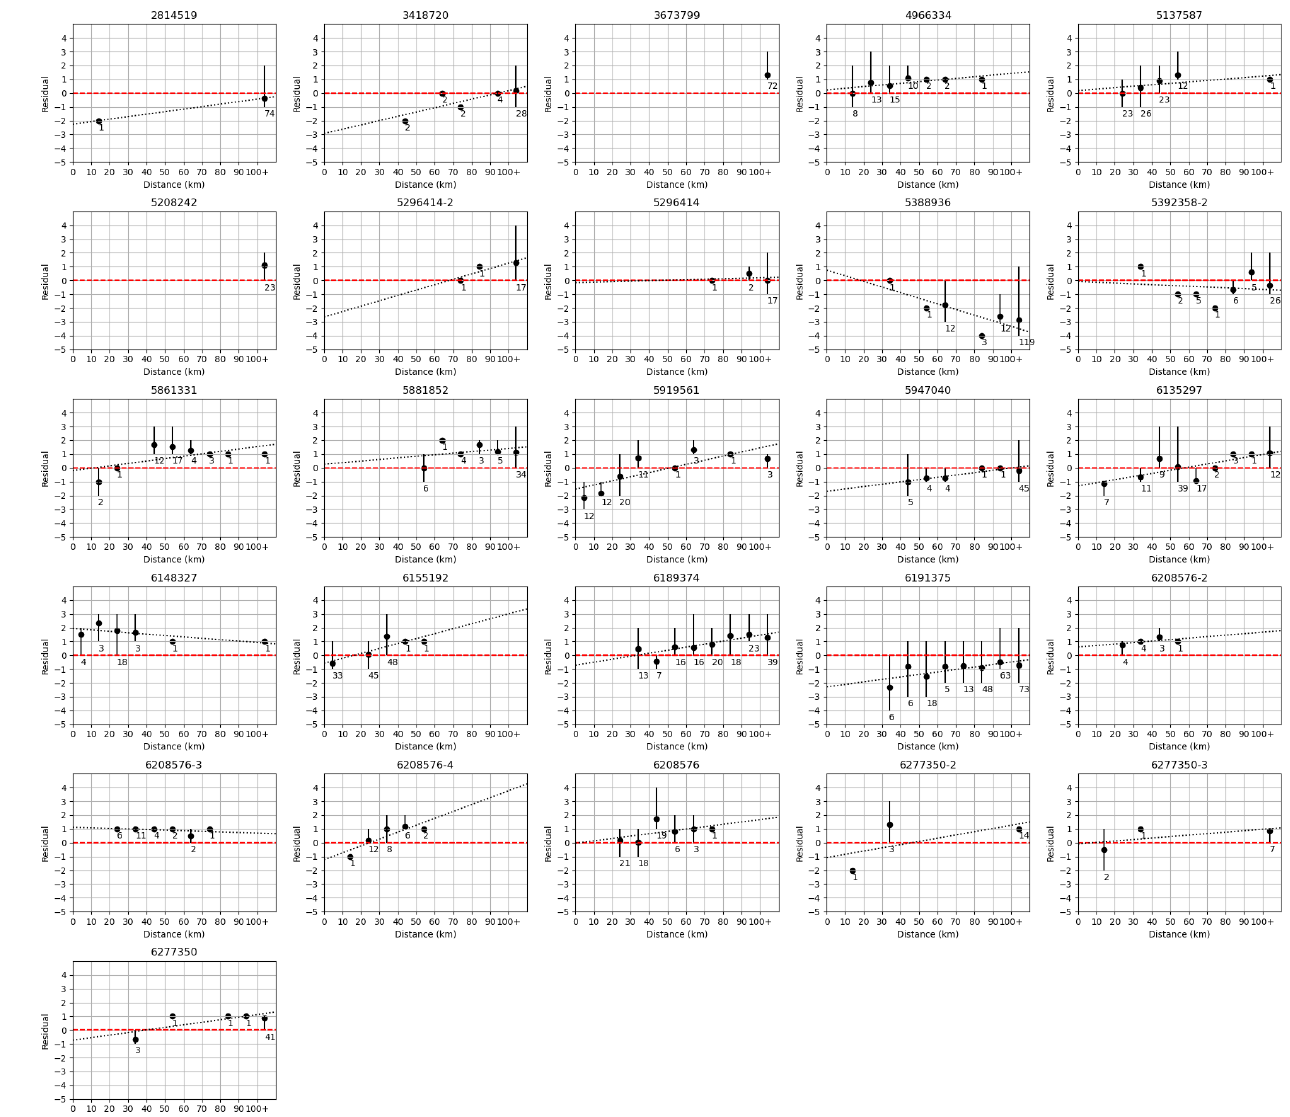
Figure 7. Residuals of predicted and observed MCSs. Red dashed line represents the baseline. Black circles are the residual of the weighted average of the bin. Vertical black lines are the residuals from predicted MCSs and minimum and maximum MCSs that are observed in the bin. The black dotted line is the fitted line to the residual of weighted averages. The number of data points inside the bins is provided beneath each bin point with data (created using Matplotlib library of